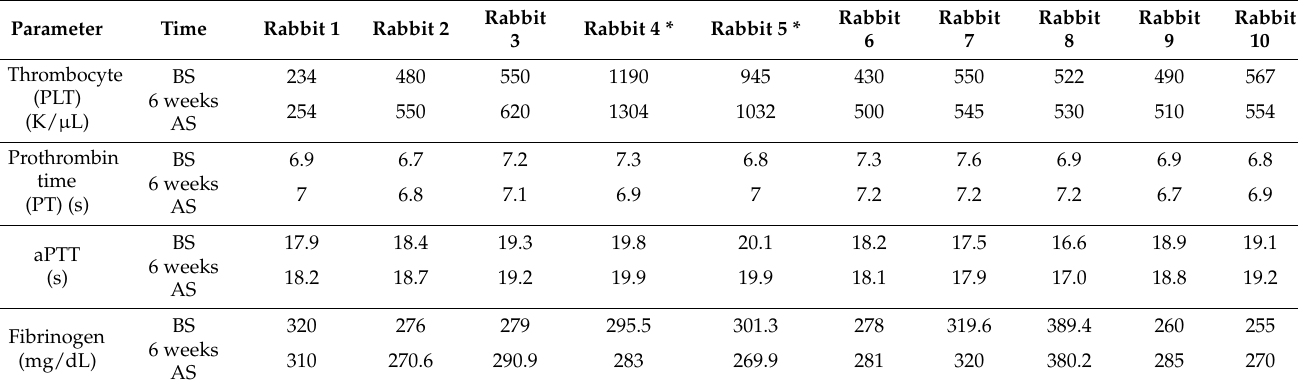
Table 12. The evolution of coagulation